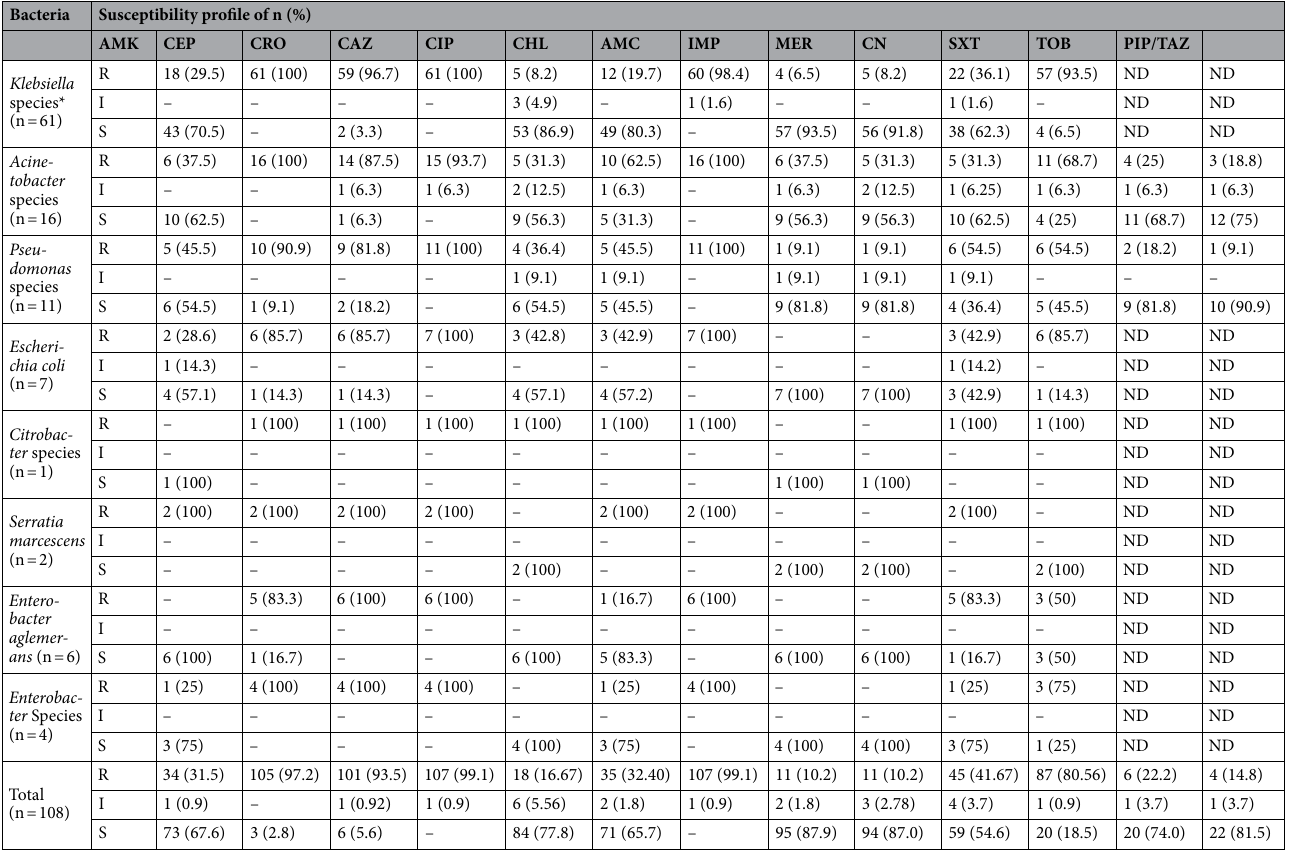
Table 5. Antibiotic Susceptibility Patterns of Gram-Negative Bacteria isolated from newborn suspected of sepsis at Hawassa University Comprehensive Specialized Hospital February 2021 to November 2021